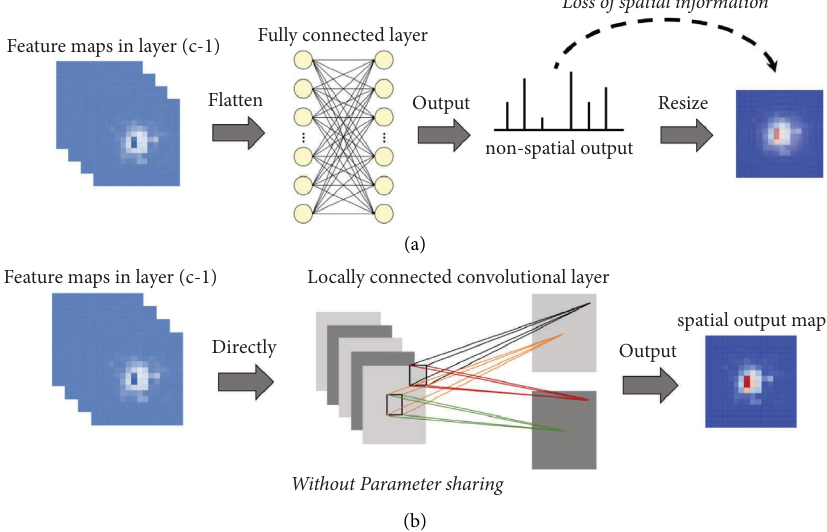
Figure 4: Schematic diagram showing the transformation of fully connected layers into locally connected convolution layers to output a heatmap. (a) Te fully connected layers take spatial inputs and produce nonspatial outputs. (b) Transforming fully connected layers into locally connected convolutional layers to avoid spatial information